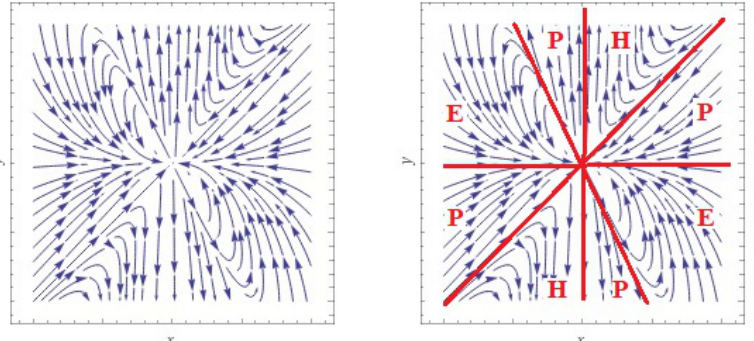
Figure 1. Typical plane phase trajectories near equilibrium point of map f ( x , y ) . Here H is a hyperbolic sector, P is parabolic and E is an elliptic sector